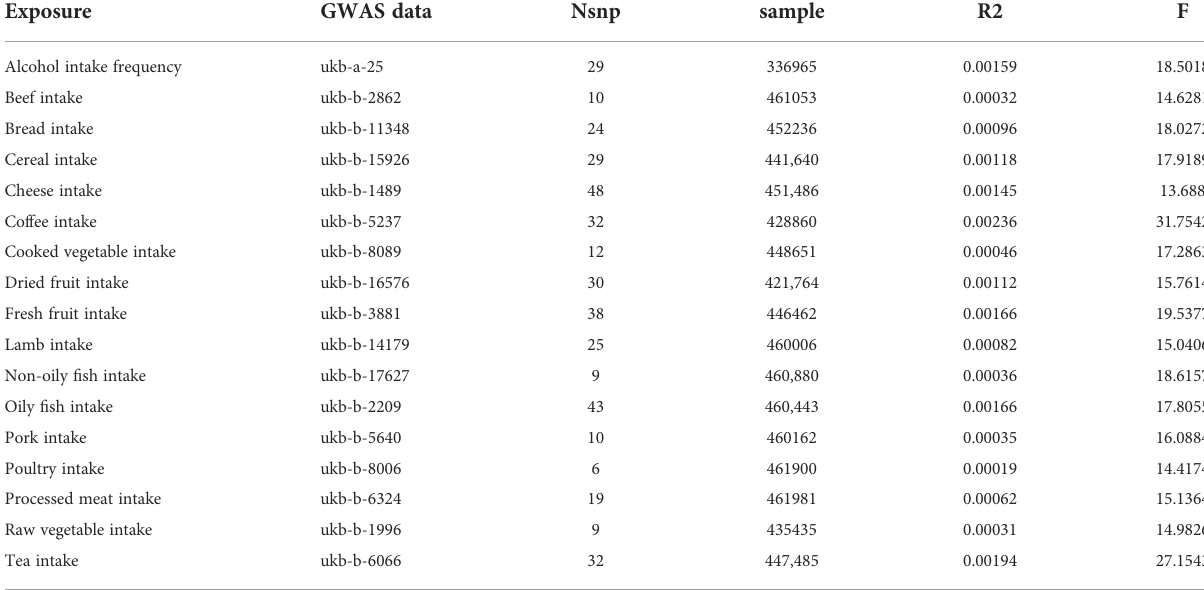
TABLE 2 Summary of modi fi able risk factors for